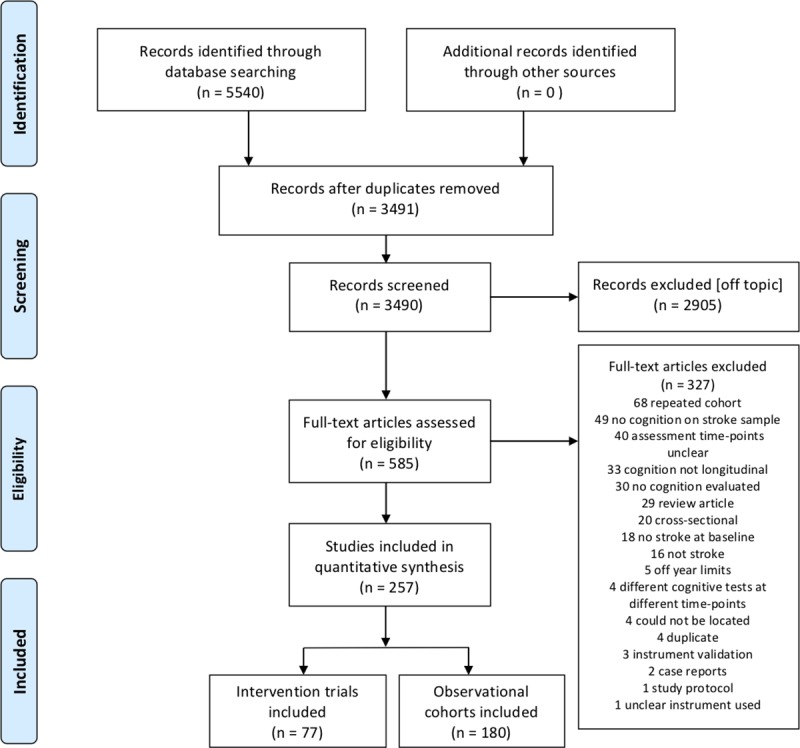
Included studies and reasons for exclusion.